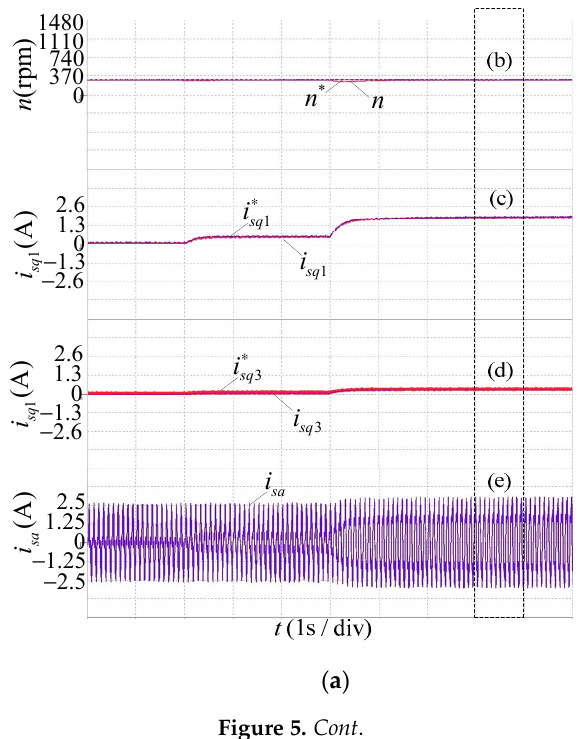
( e ) Figure 5. Experimental waveform of model predictive control and field-oriented control (MPC+FOC) system at 300 r/min, showing ( a ) the whole process; ( b ) the speed n ; ( c ) the current